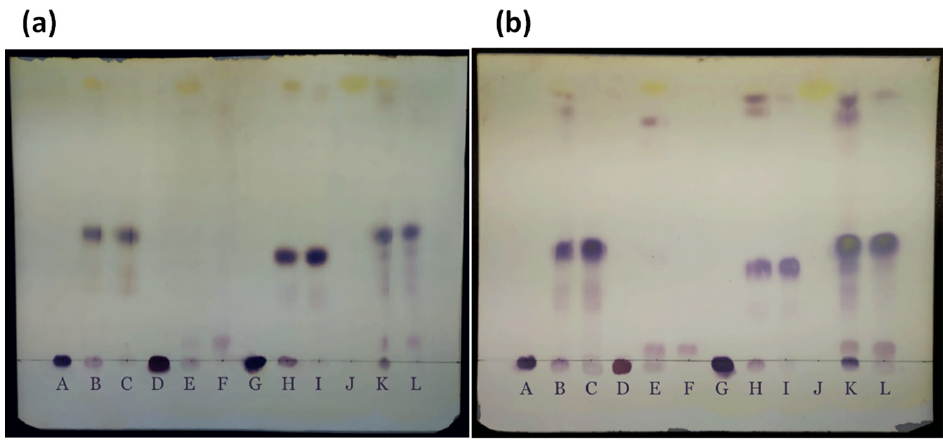
Figure 1. Thin Layer Chromatogram (TLC) of reaction mixtures of stearoyl esters synthesis ( a ), lau- royl esters synthesis ( b ) and pure products obtained after purification steps. Sugars standars